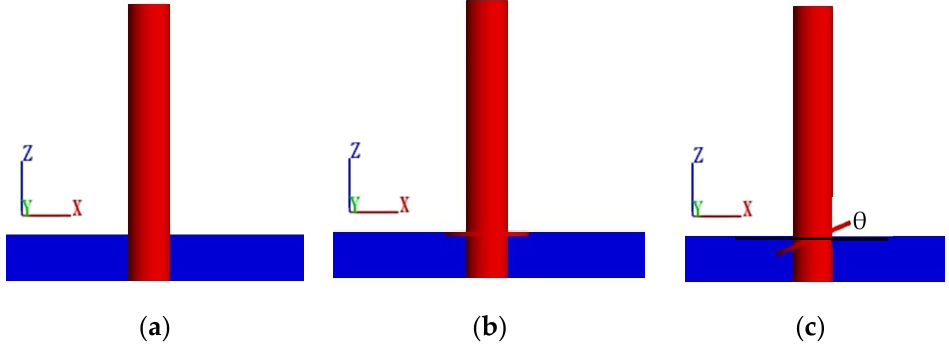
Figure 7. The models of Case 1, Case 2, and Case 6. ( a ) Case 1 (without circular collar). ( b ) Case 2 (θ = 0°). ( c ) Case 6 (θ = 20°).